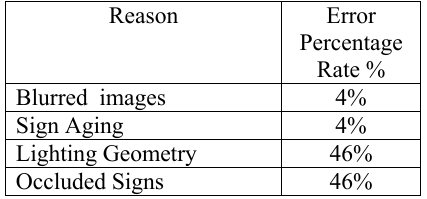
Table 3. Reasons for false